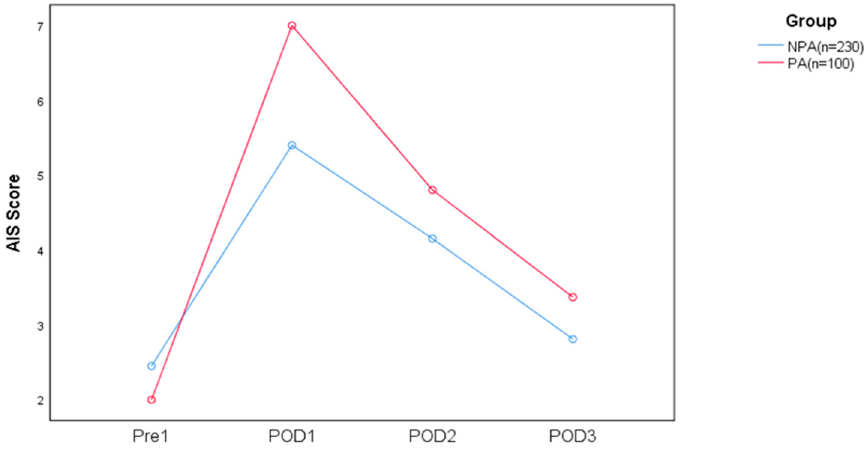
Figure 2. Comparison of sleep quality between the PA and NPA groups.